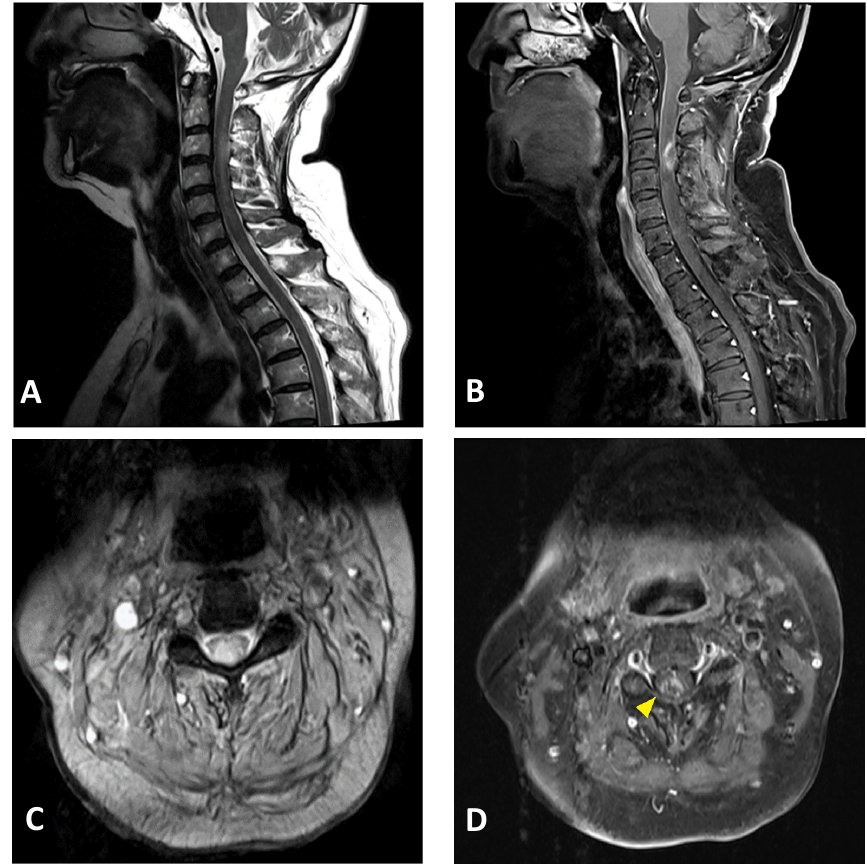
Figure 2. Cervical MRI images of a 76-year-old female with longitudinally extensive transverse myelitis: ( A ) sagittal T2-weighted image showing hyperintensity in the cervical cord at the C2–C5 levels; ( B ) sagittal T1-weighted image with contrast showing ring enhancement in the cervical cord at the C3 level; ( C ) axial T2-weighted image showing extensive hyperintensity in the cervical cord at the C3 level; ( D ) axial T1-weighted image with contrast showing right-sided enhancement in the cervical cord at the C3 level (arrowhead).